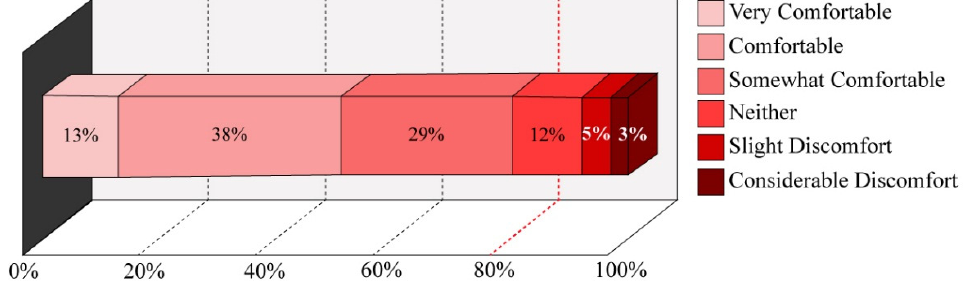
Figure 4. Results from thermal comfort questionnaire. Adapted with permission from CiNii